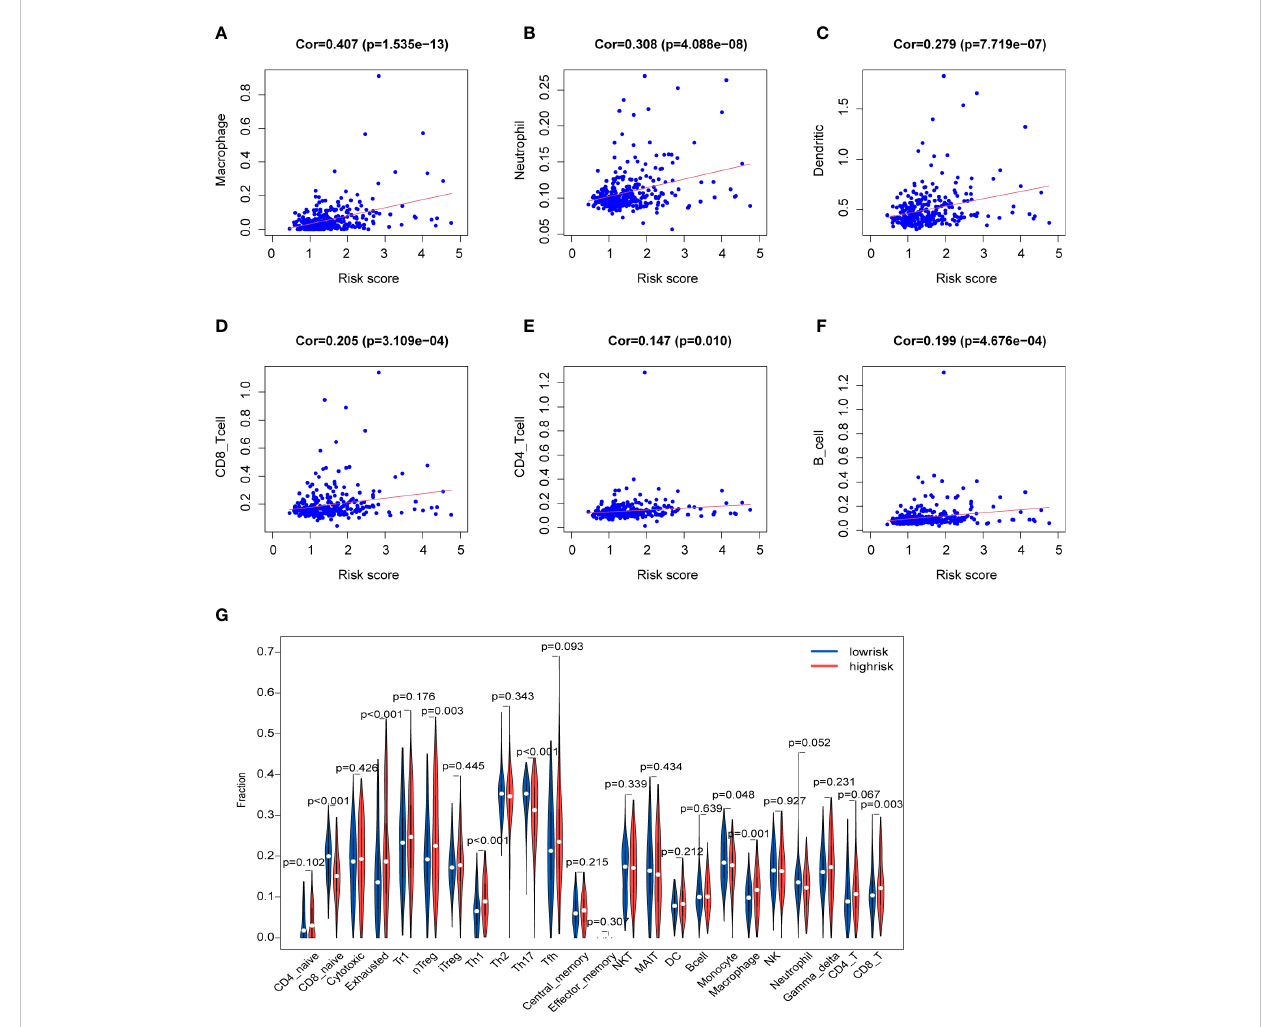
FIGURE 9 Characteristics of immune microenvironment (A-F) Relationships between the risk score and in fi ltration abundances of six types of immune cells. (G) Comparison of immune cell